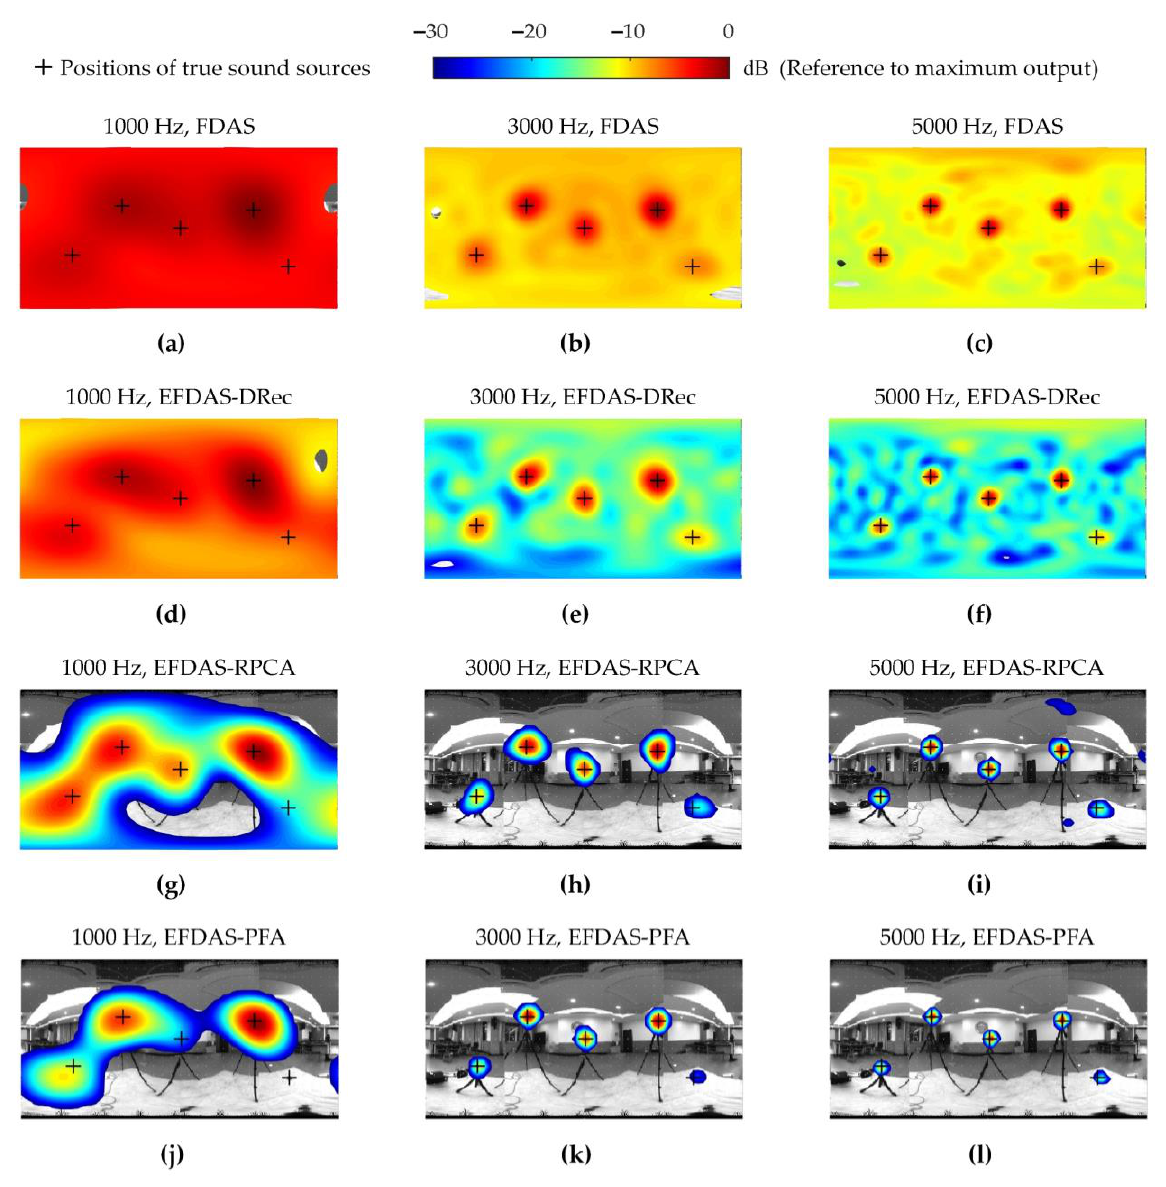
Figure 11. Acoustic imaging colormaps of the experiment: ( a – c ) Maps of FDAS at 1000 Hz, 3000 Hz, and 5000, respectively; ( d – f ) Maps of EFDAS-DRec at 1000 Hz, 3000 Hz, and 5000, respectively; ( g – i ) Maps of EFDAS-RPCA at 1000 Hz, 3000 Hz, and 5000, respectively; ( j – l ) Maps of EFDAS-RPCA at 1000 Hz, 3000 Hz, and 5000 Hz, respectively.